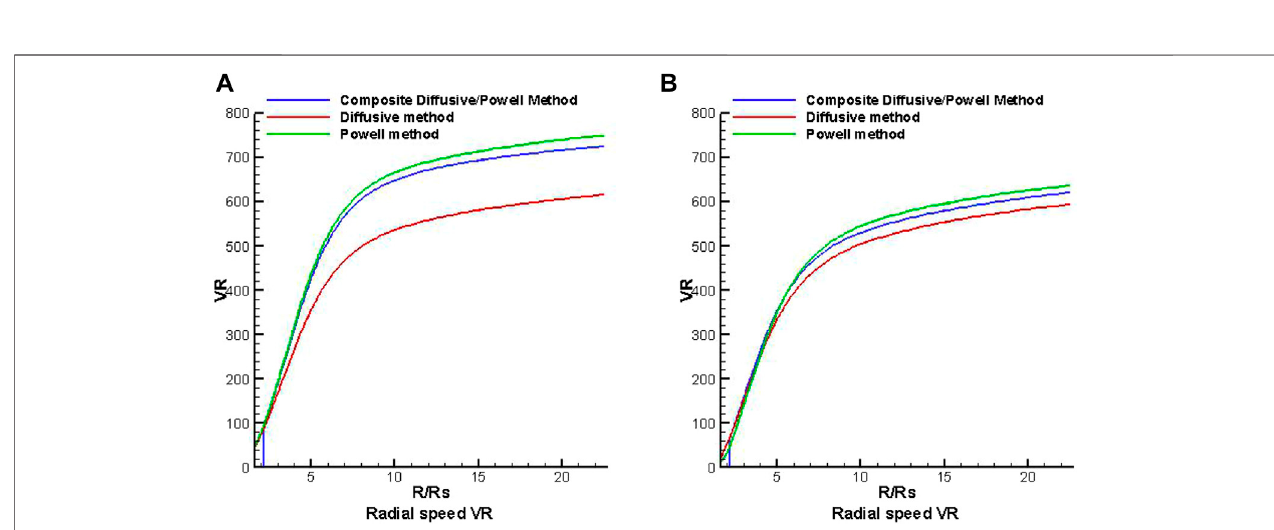
FIGURE3| Thedistributionofradialspeed VR (km/s)alongheliocentricdistancewithdifferentlatitudesof θ (cid:2)− 80 ° (A) and θ (cid:2)− 10 ° (B) atthesamelongitude Φ (cid:2) 0 ° from three divergence